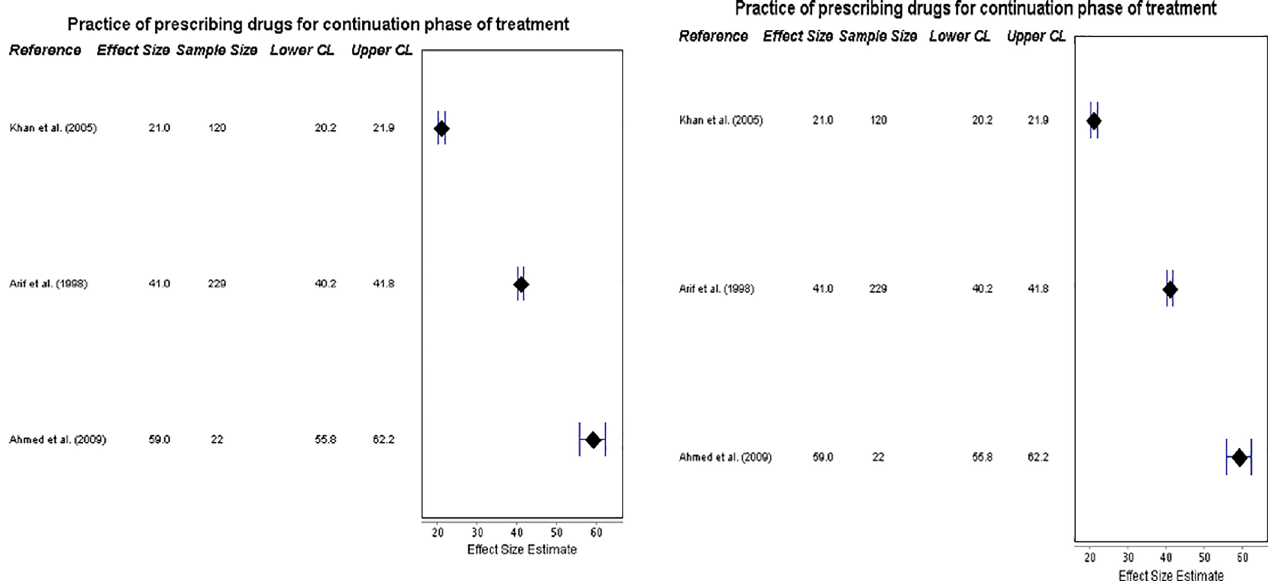
Fig 4. Forest plots on prescriptions for intensive and continuation phases. (a) Forest plot visualizing data on practitioners’ compliance with prescribing drugs for the intensive phase of TB treatment (ISTC Standard 8). CL = 95% Confidence Level. (b) Forest plot visualizing data on practitioners’ compliance with prescribing drugs for the continuation phase of TB treatment (ISTC Standard 8). CL = 95% Confidence Level.